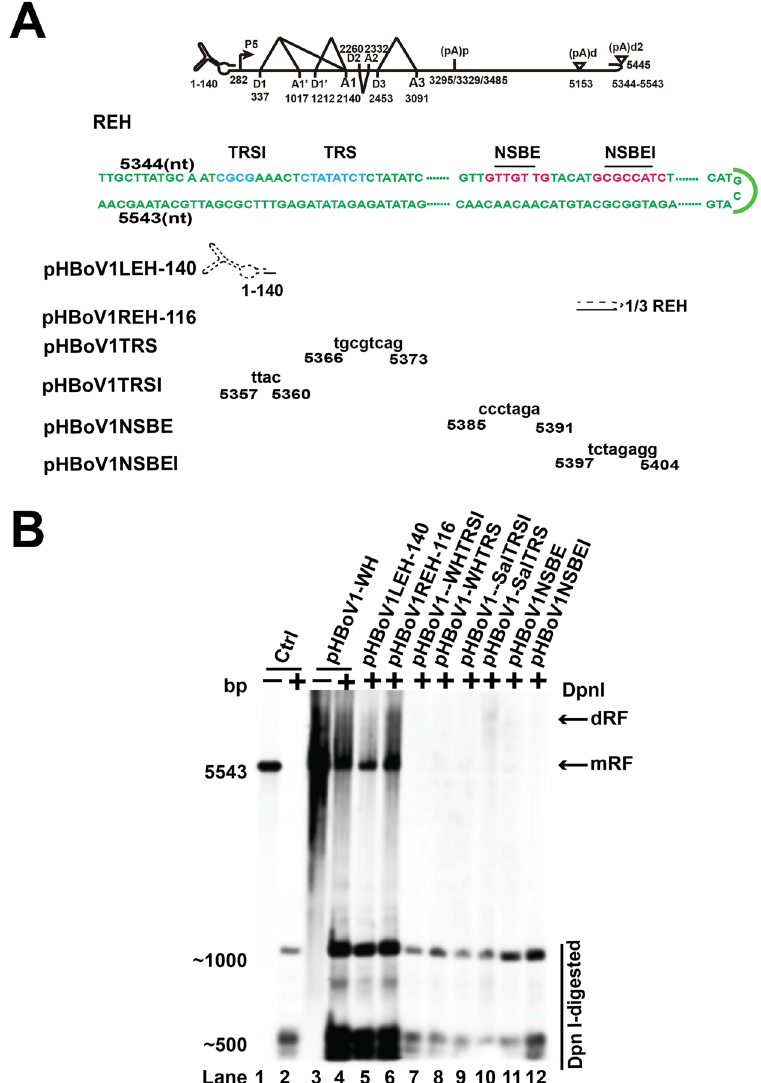
Figure 7. Identification of the cis- elements that regulate HBoV1 viral DNA replication. Diagram of LEH, REH, trs and NS1 binding elements mutated plasmids. LEH: Left end hairpin. REH: right end hairpin. trs : terminal resolution site. ( B ) Southern blot analysis. Hirt DNA was harvested from HEK293T cells transfected with plasmids in panel A. Southern blot analysis was performed as described in Fig.